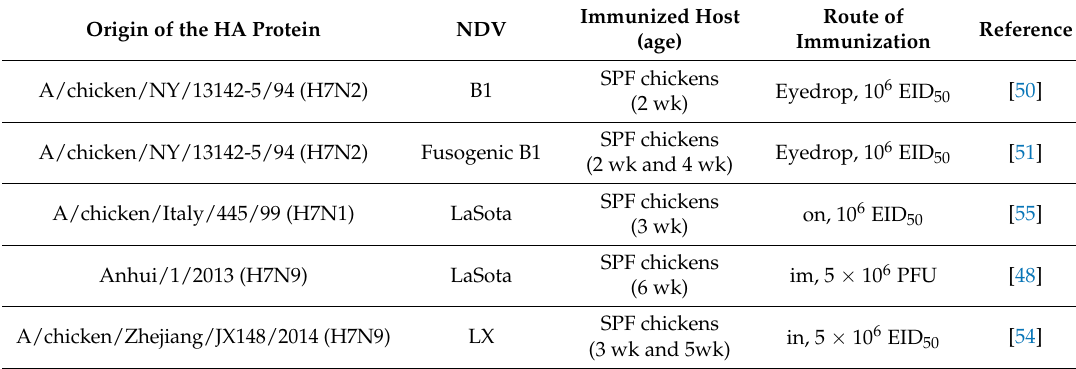
Table 2. NDV-vectored vaccines against H7